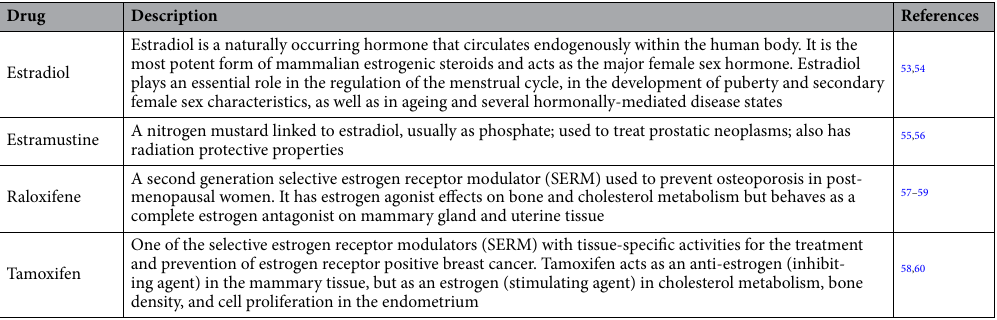
Table 1. Detail information about Estradiol, Estramustine, Raloxifene and Tamoxifen.